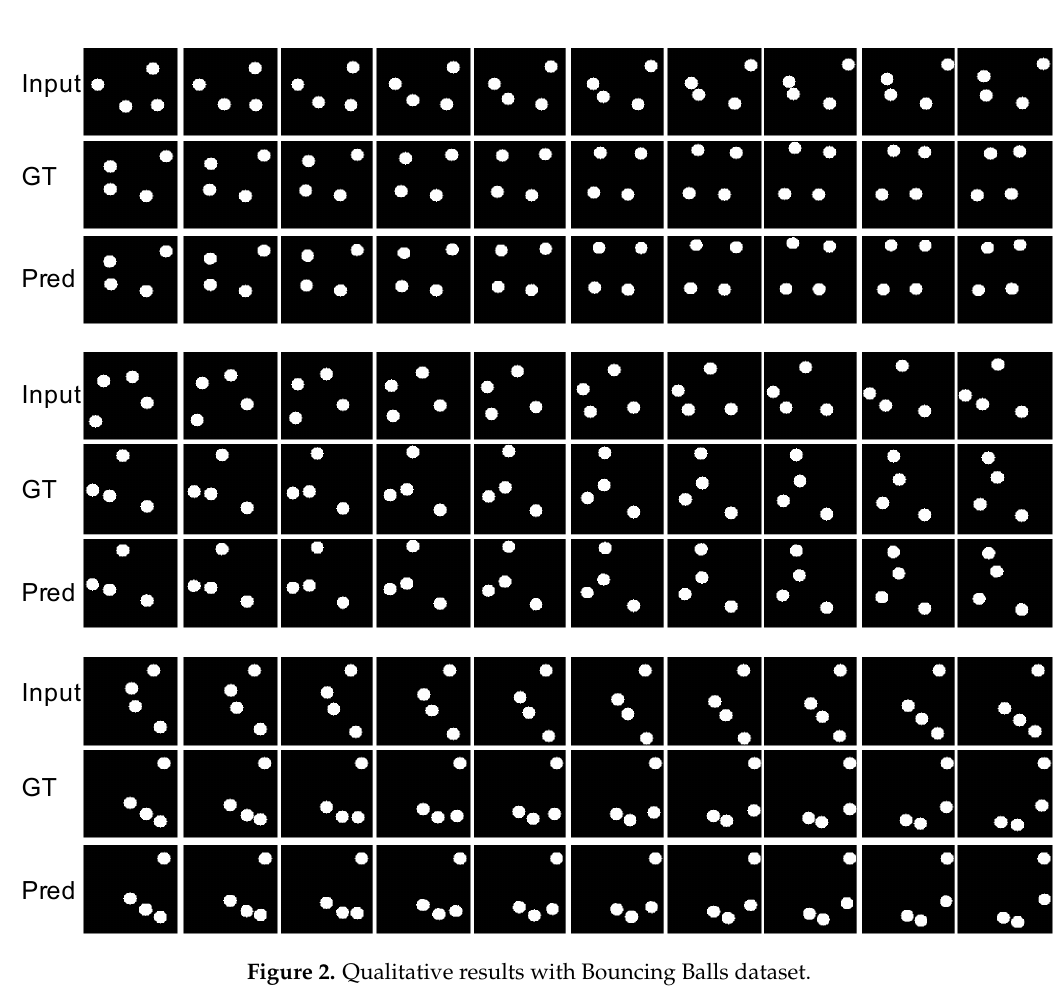
Figure 2. Qualitative results with Bouncing Balls dataset.